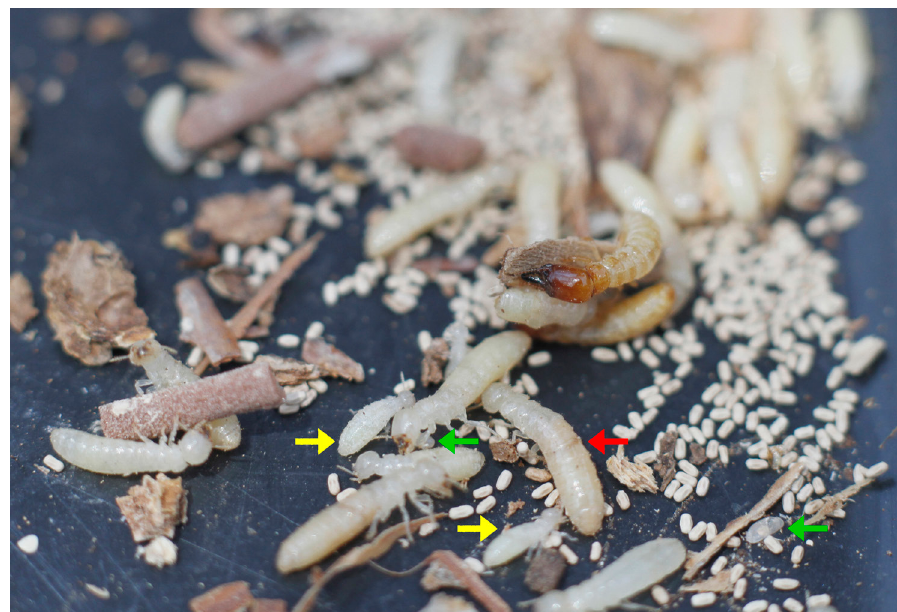
Figure S1. Macrophotography of P. macondianus sp. n. alive from National Park Tayrona. Santa Marta. Magdalena Colombia. Two soldiers (one partly hidden), some pseudergates (whitish, red arrow), two larva (yellow arrow), two eggs (green arrow), and some dry pellets.